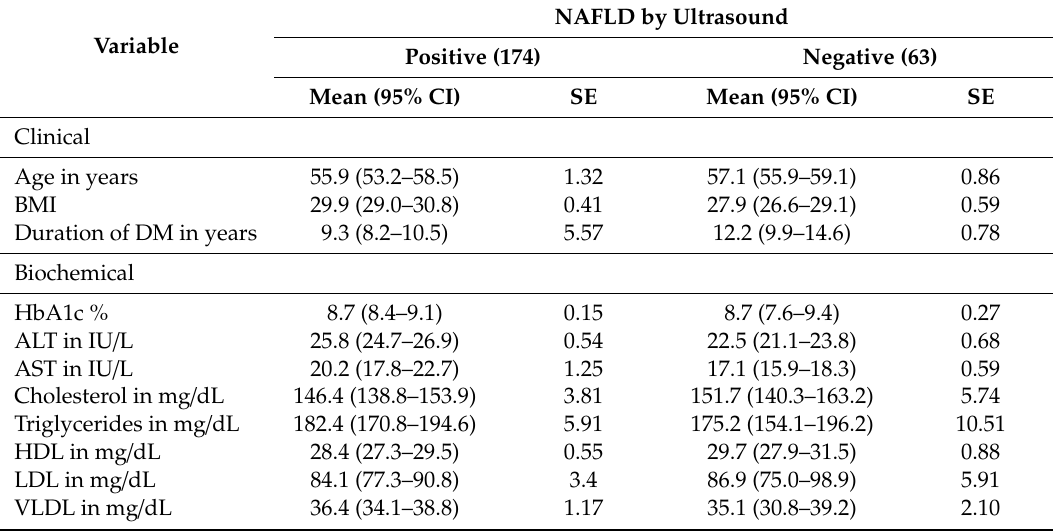
Table 1. Arithmetic mean, 95% confidence intervals of the mean, and standard error of the mean of clinical and biochemical variables among type 2 diabetes (T2DM) patients (237) with and without nonalcoholic fatty liver disease (NAFLD) in Abha